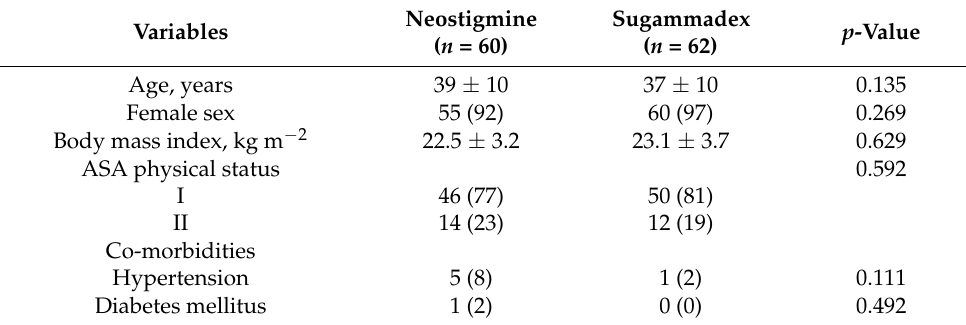
Table 1. Demographic characteristics of